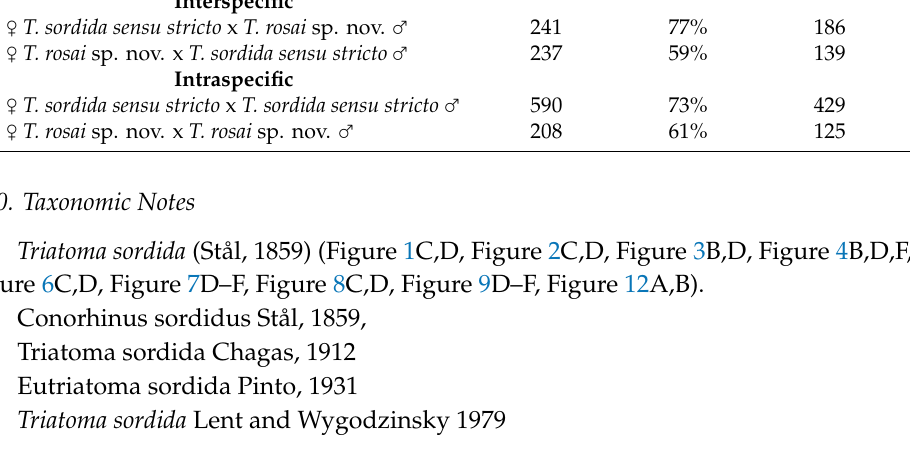
Hatching Number of Mortality Eggs Rate Nymphs Rate